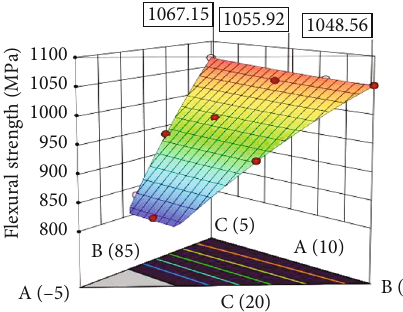
Figure 15: The e ff ect of fi ber, matrix, and fi ller weight % on fl exural